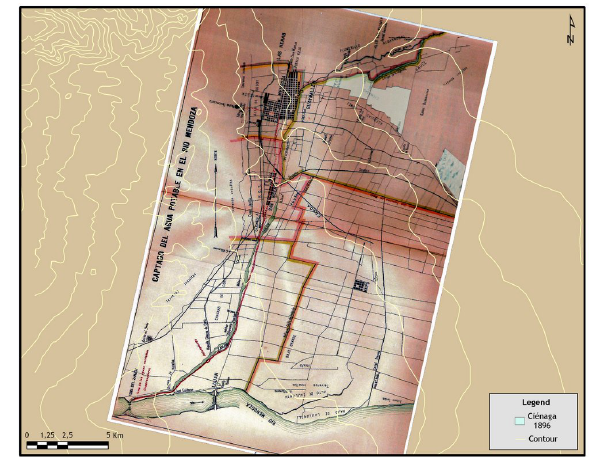
Fig. 8. The Bermejo Wetland in 1896 according C´esar Cipolletti map (Coni,